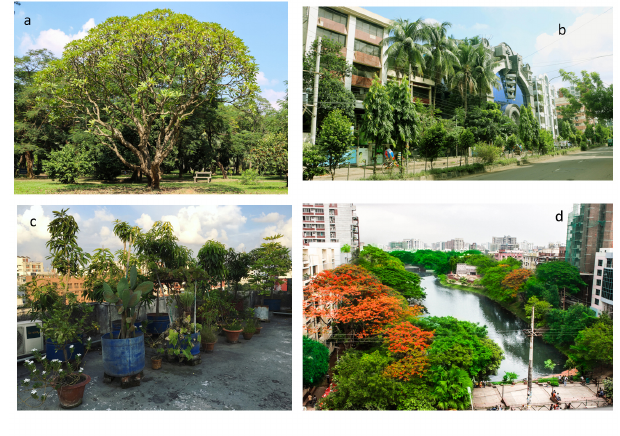
Fig. 2 . Green spaces in the study site. (a) green park (b) street- side greenery (c) rooftop garden (d) green